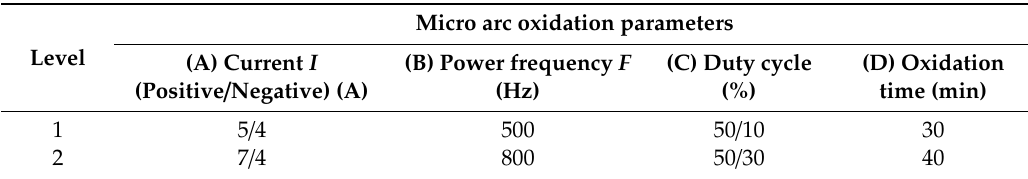
Table 1. Experimental parameters of the orthogonal